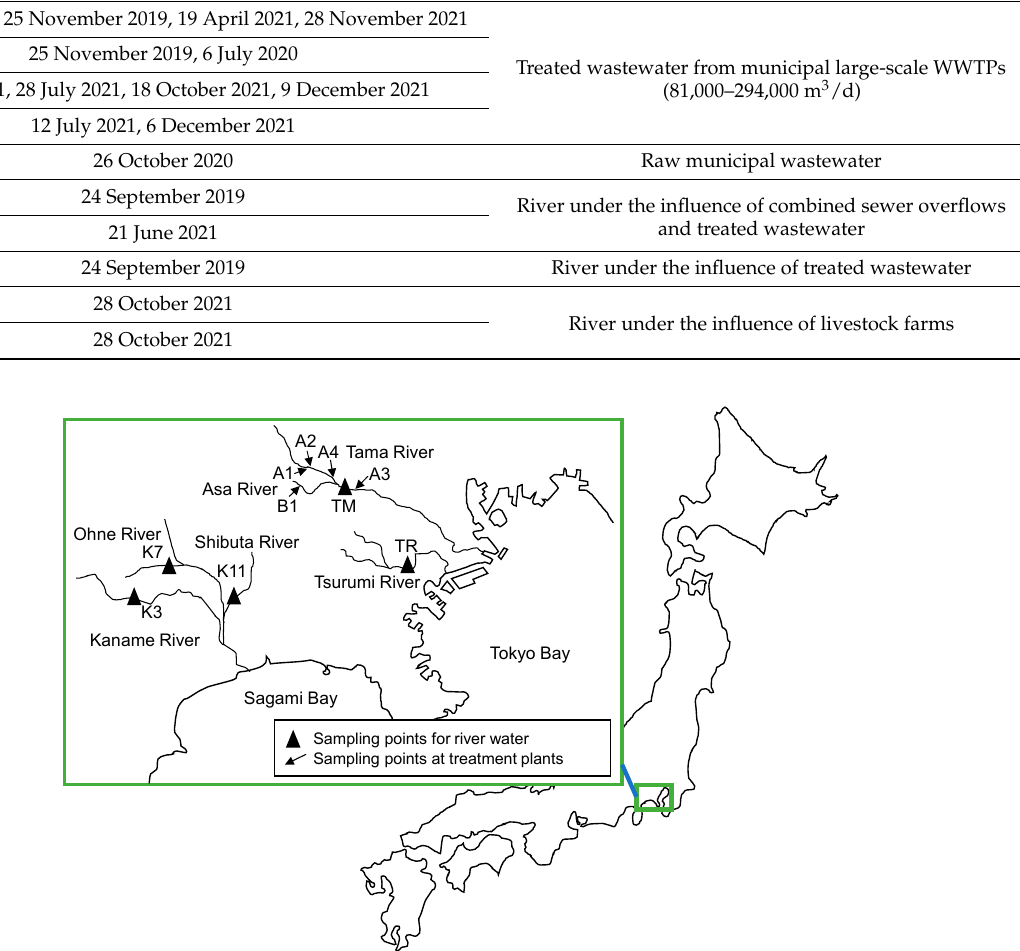
Table 5. Sample origins for the collection of CRE.